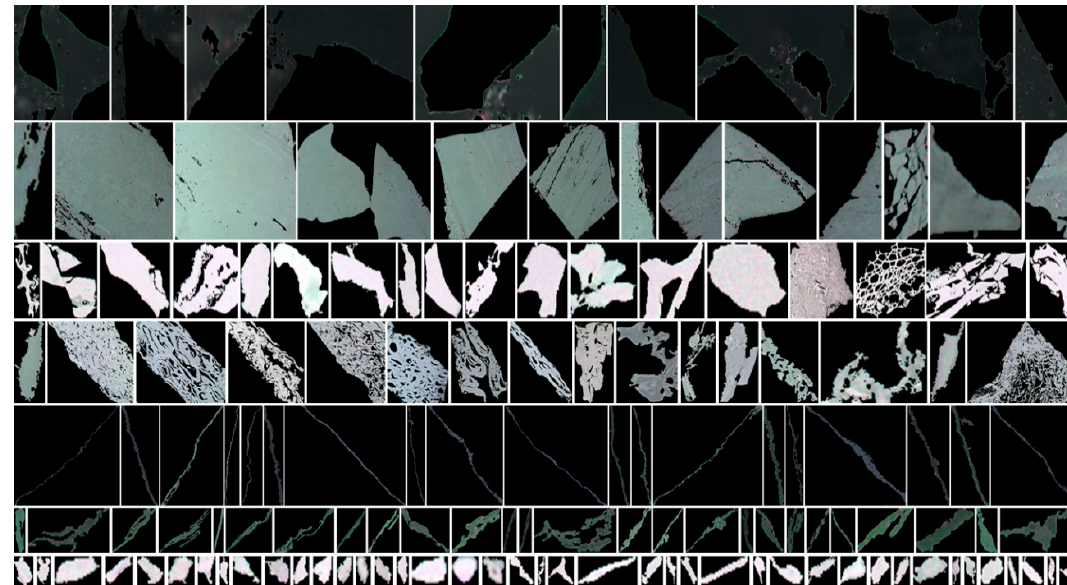
Figure 1. Examples of maceral components and binder. Each row represents a class. They are binder, vitrinite, fusinite, semifusinite, cutinite, sporinite and inertodetrinite from top to bottom respectively. The black color areas (i.e., RGB value = 0) in each figure represent the background of the given maceral component. The micrinite is not shown here for its small size accounting for only a few pixels.